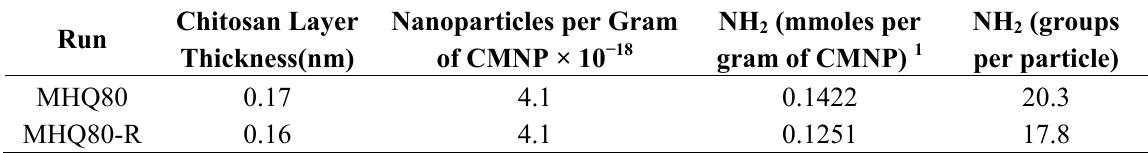
Table 2. Surface features and nanoparticle number per mass unit of the chitosan-coated magnetic